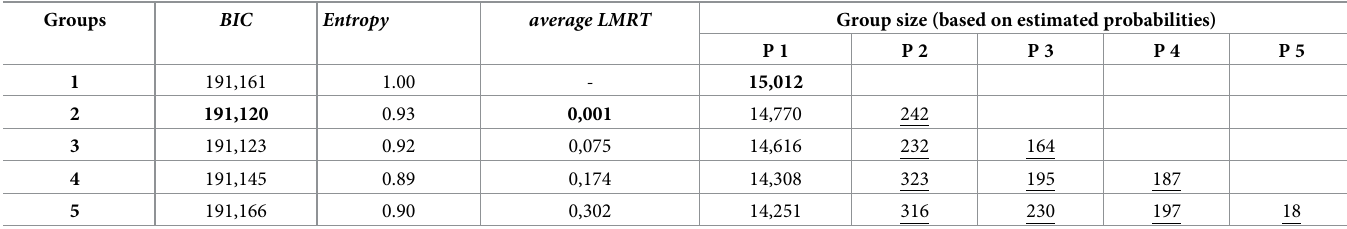
Table 5. Model fit and profile sizes of the LGM and